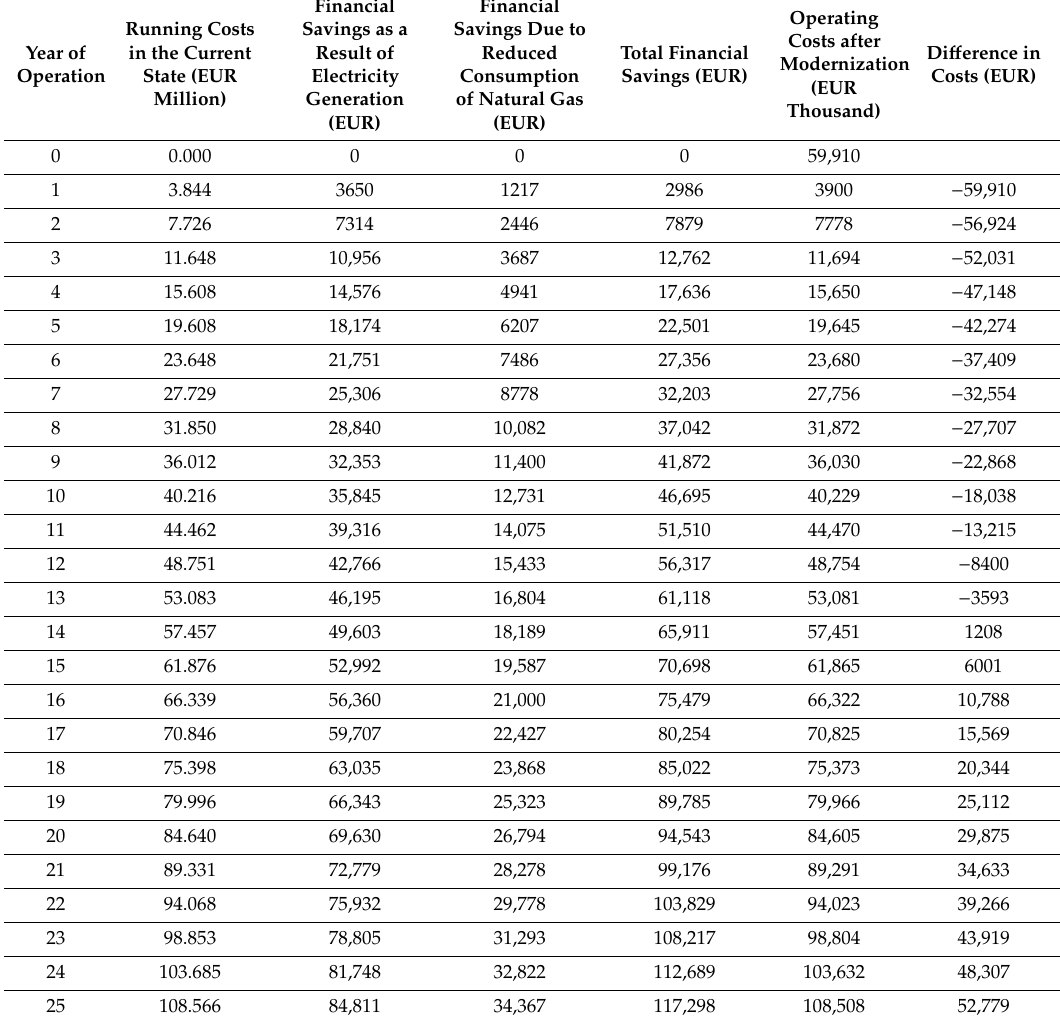
Table 6. Comparison of total costs resulting from the exploitation of electricity and natural gas in the existing state and after the assembly of PV